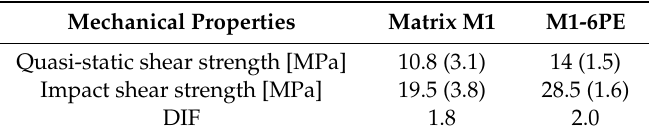
Table 5. Quasi-static and impact shear strengths of M1-6PE and its non-reinforced matrix (standard deviations are given in